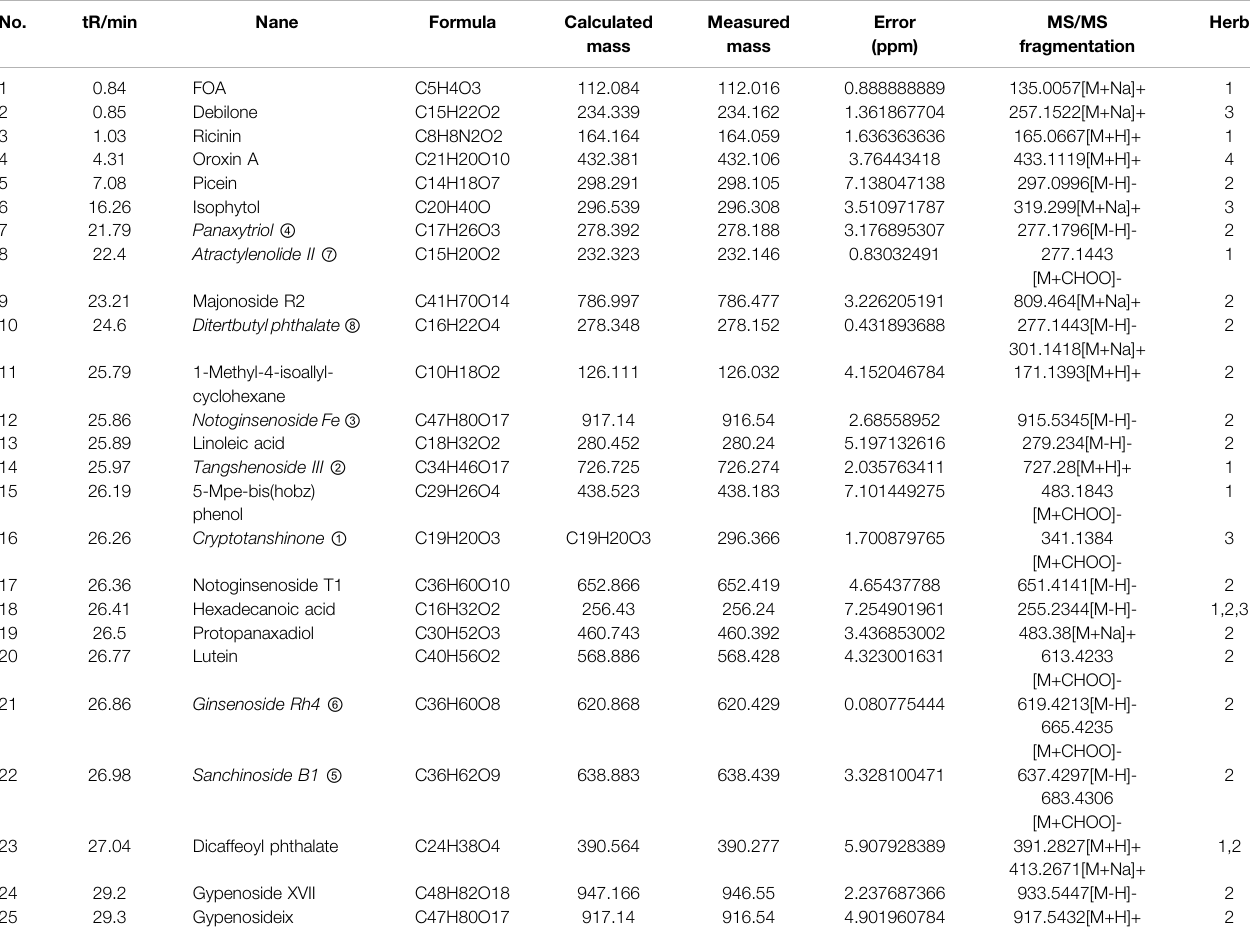
TABLE 2 | Main components of serum after treatment of